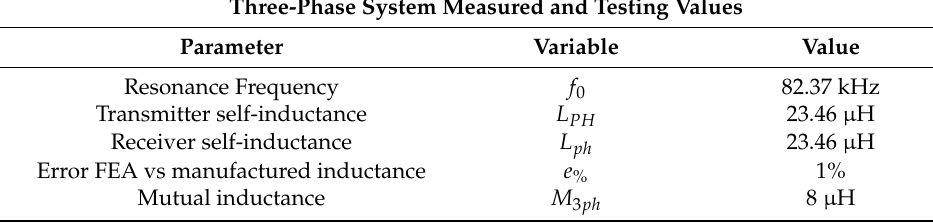
Table 2. Measured Parameters of the three-phase WPT unit. Three-Phase System Measured and Testing Values Parameter Variable Value Resonance Frequency f 0 Transmitter